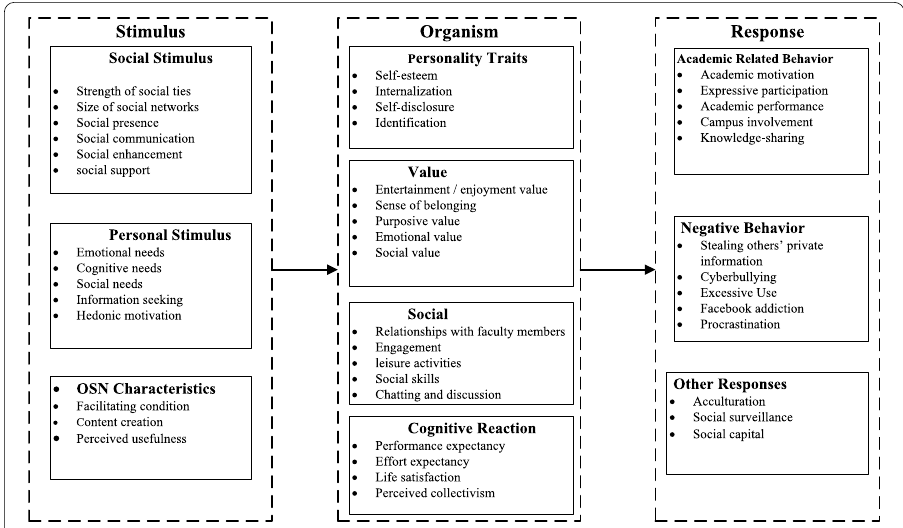
Fig. 7 Classification framework for student behaviors in online social